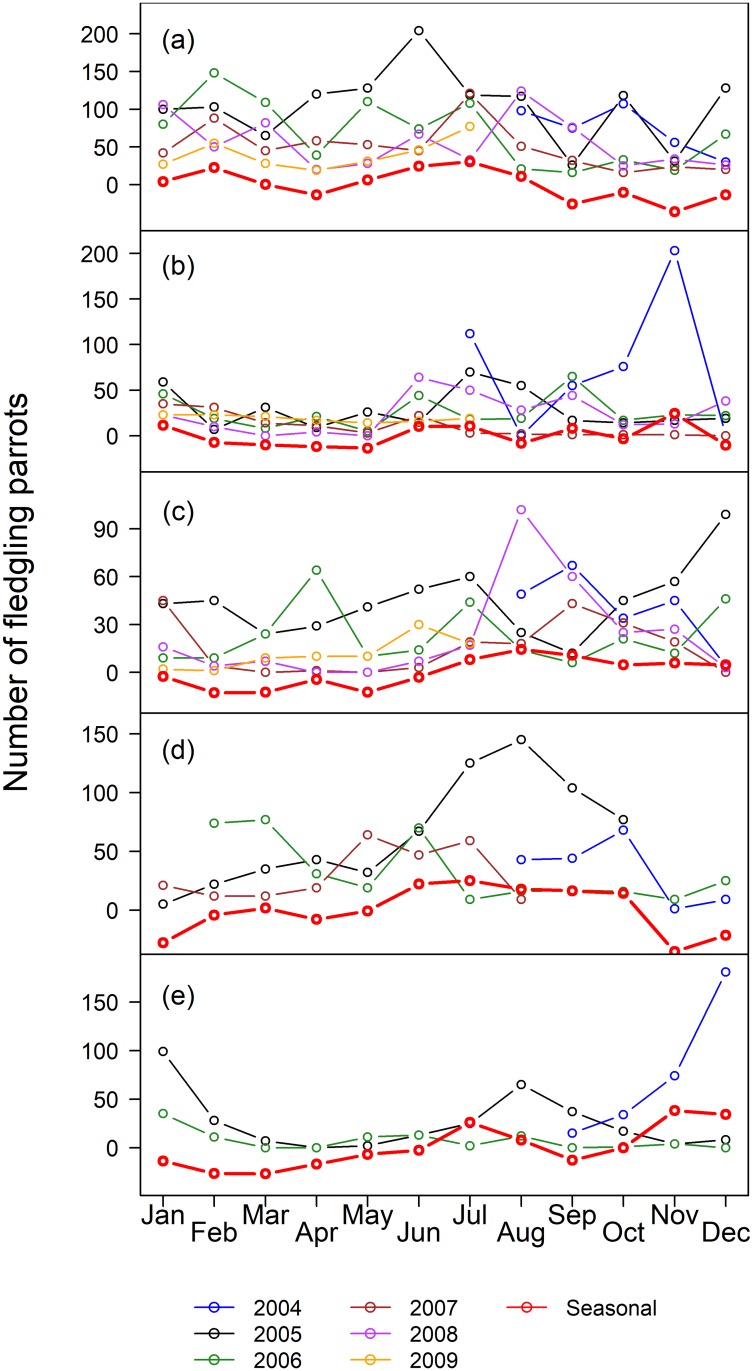
Number of fledgling parrots in five roosts in the southern Pantanal of Brazil.Years are coded by colors (see the legend below the plots), and the red line indicate the seasonal component of the counts obtained by STL-decomposition analysis (see Methods). (a) Roost 1, (b) Roost 2, (c) Roost 3, (d) Roost 4, and (e) Roost 5.